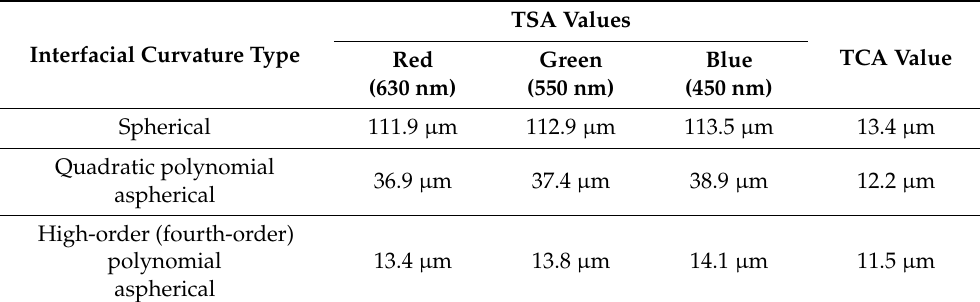
Table 2. Wavelength-dependent TSA and TCA properties of LC-GRIN lens arrays in case of using LCM 1107 as the plano-convex birefringent layer and NOA81 as the plano-convex isotropic